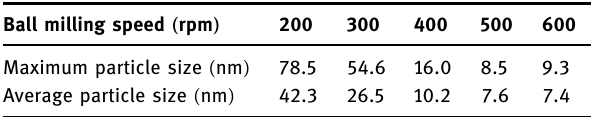
Table 1: Particle size of CdS/TiO 2 composite photocatalysts